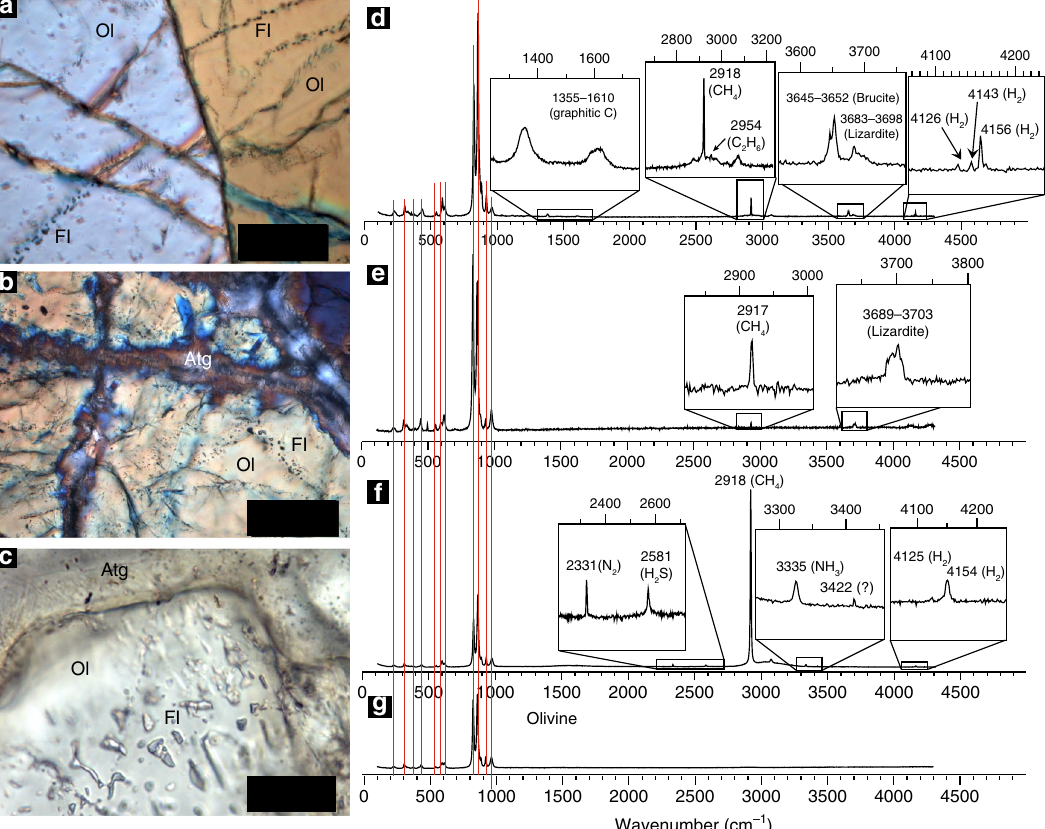
Fig. 3 H 2 -CH 4 -rich fl uid inclusions. a – c Photomicrographs of olivine-hosted fl uid inclusions (FI) in partially serpentinized pseudotachylyte-bearing peridotites. Note the presence of the fl uid inclusions along secondary trains propagating from serpentinized cracks and cross-cutting the primary olivine ( a , b ), suggesting their formation during the serpentinization events. d – g MicroRaman spectra of the fl uid inclusions shown in a – c . The spectrum of the host olivine ( g ) is shown for reference. Note the presence of CH 4 and H 2 also in fl uid inclusions free of daughter minerals, suggesting that the initial fl uid trapped in the inclusions was already reduced. See Supplementary Fig. 13 for additional details. Scale bars: a , b 50 µ m; c 20 µ